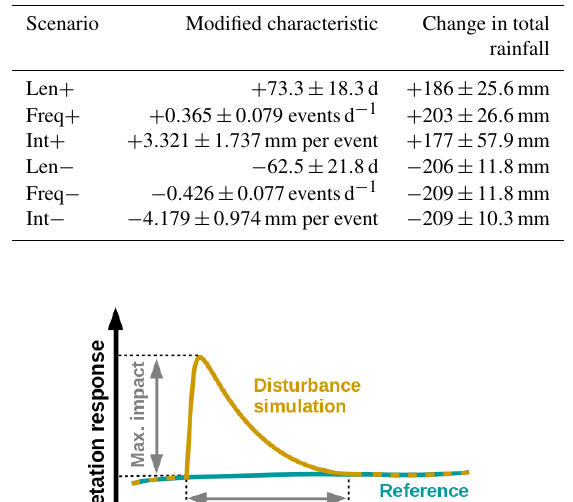
Table 4. Overview of the scenarios with actual rainy-season char- acteristic values for the Dahra site (average and standard deviation taken over all ensemble members).